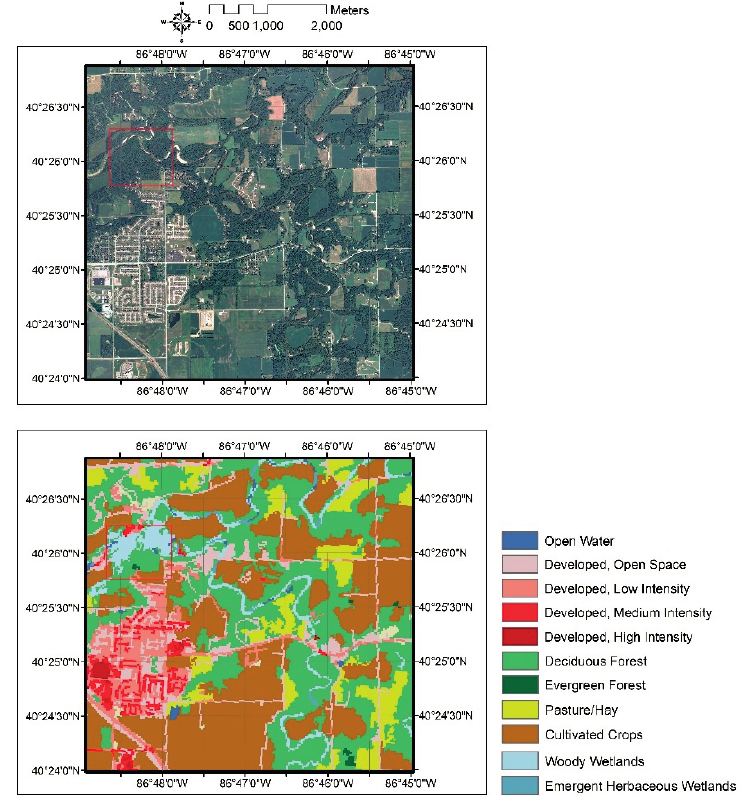
Figure 1. A visual comparison of the subset of a digital aerial photograph which was taken in 2006, and NLCD 2006 in an area of 6.0 × 7.5 km 2